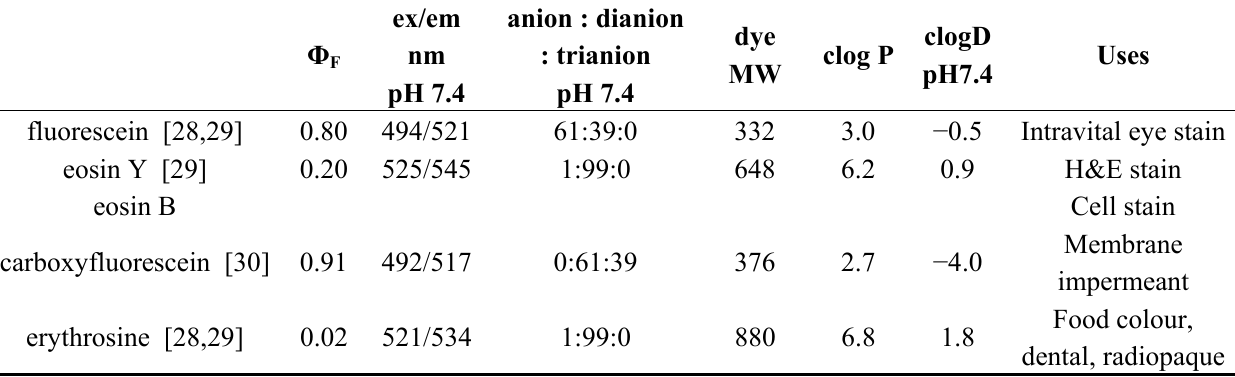
Table 4. Physicochemical properties of fluorescein derivatives approved for use in humans.